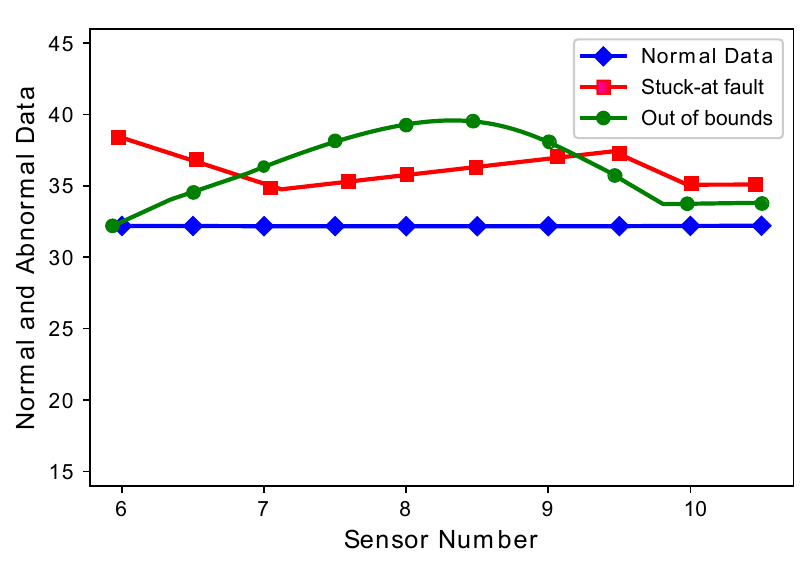
Figure 5. Normal and abnormal sensor